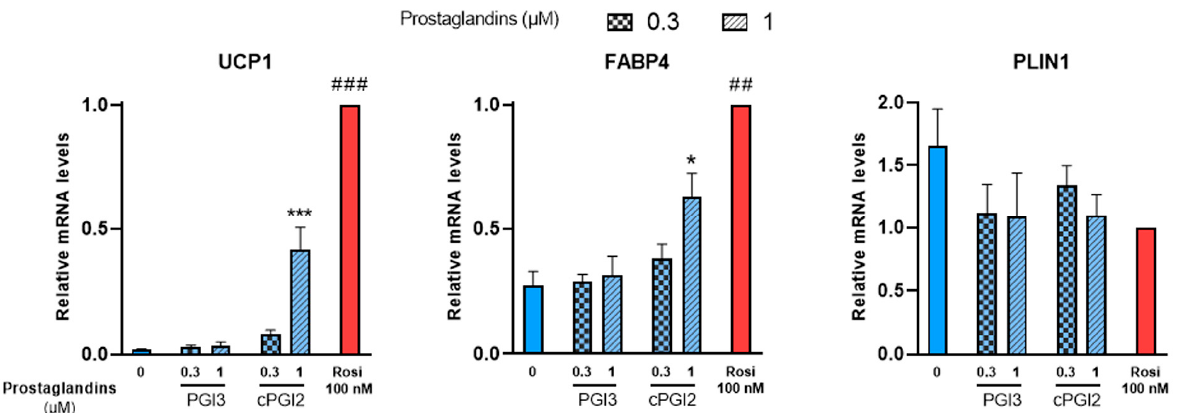
Figure 2. PGI3 does not induce thermogenic markers, unlike cPGI2. White hMADS adipocytes (blue columns) were induced to convert (from day 14 to day 18) into brite adipocytes (red comumns) in the presence of various amounts of PGI3, using cPGI2 and the PPAR γ agonist rosiglitazone (Rosi 100 nM) as positive controls. mRNA levels of UCP1, FABP4 and PLIN1 markers were measured. Histograms display mean ± SEM of three to six independent experiments; statistics were conducted through a one-way ANOVA with Dunett’s multiple comparisons test, where p < 0.05 was considered significant: *: p < 0.05, ***: p < 0.001, treated vs. untreated; ##: p < 0.01, ###: p < 0.001, vs. 1 µM cPGI2 treatment.